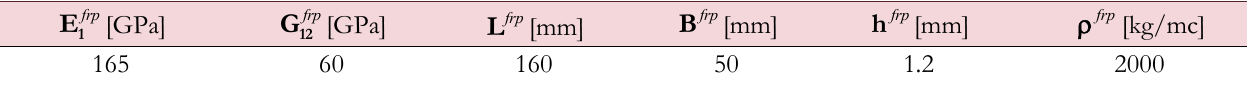
Table 5: Geometrical and mechanical properties of the Frp strip.